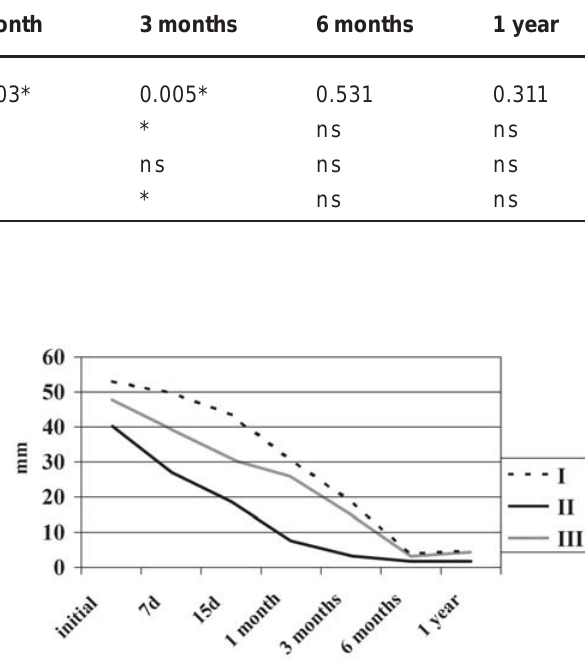
TABLE 2 - Analysis between groups (Kruskal Wallis test) for pain report Exam.